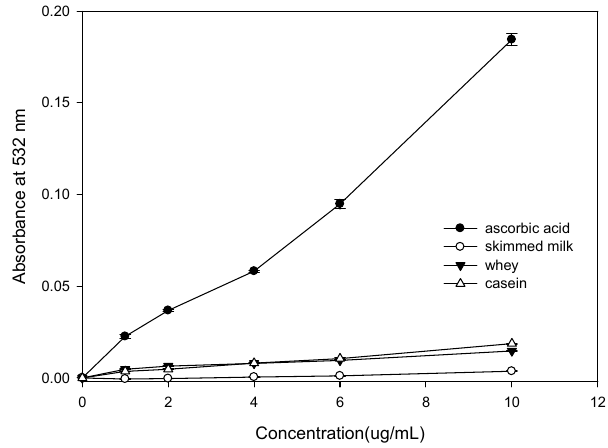
Figure 3. Effect of bovine colostrum on DNA damage induced by bleomycin-Fe 3+ .